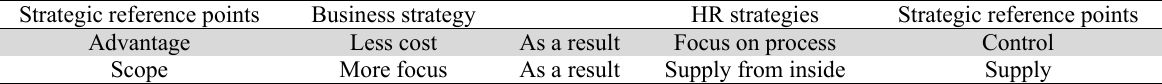
Basis of alignment in strategies based on low cost and high focus Strategic reference points